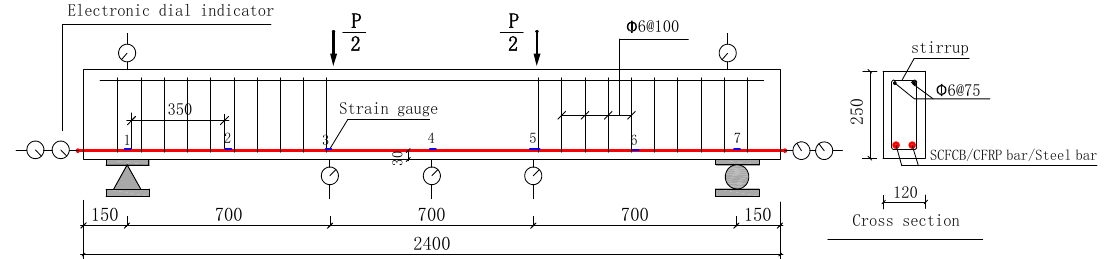
Figure 2. Test rigs and dimension, reinforcement detail of test beams.